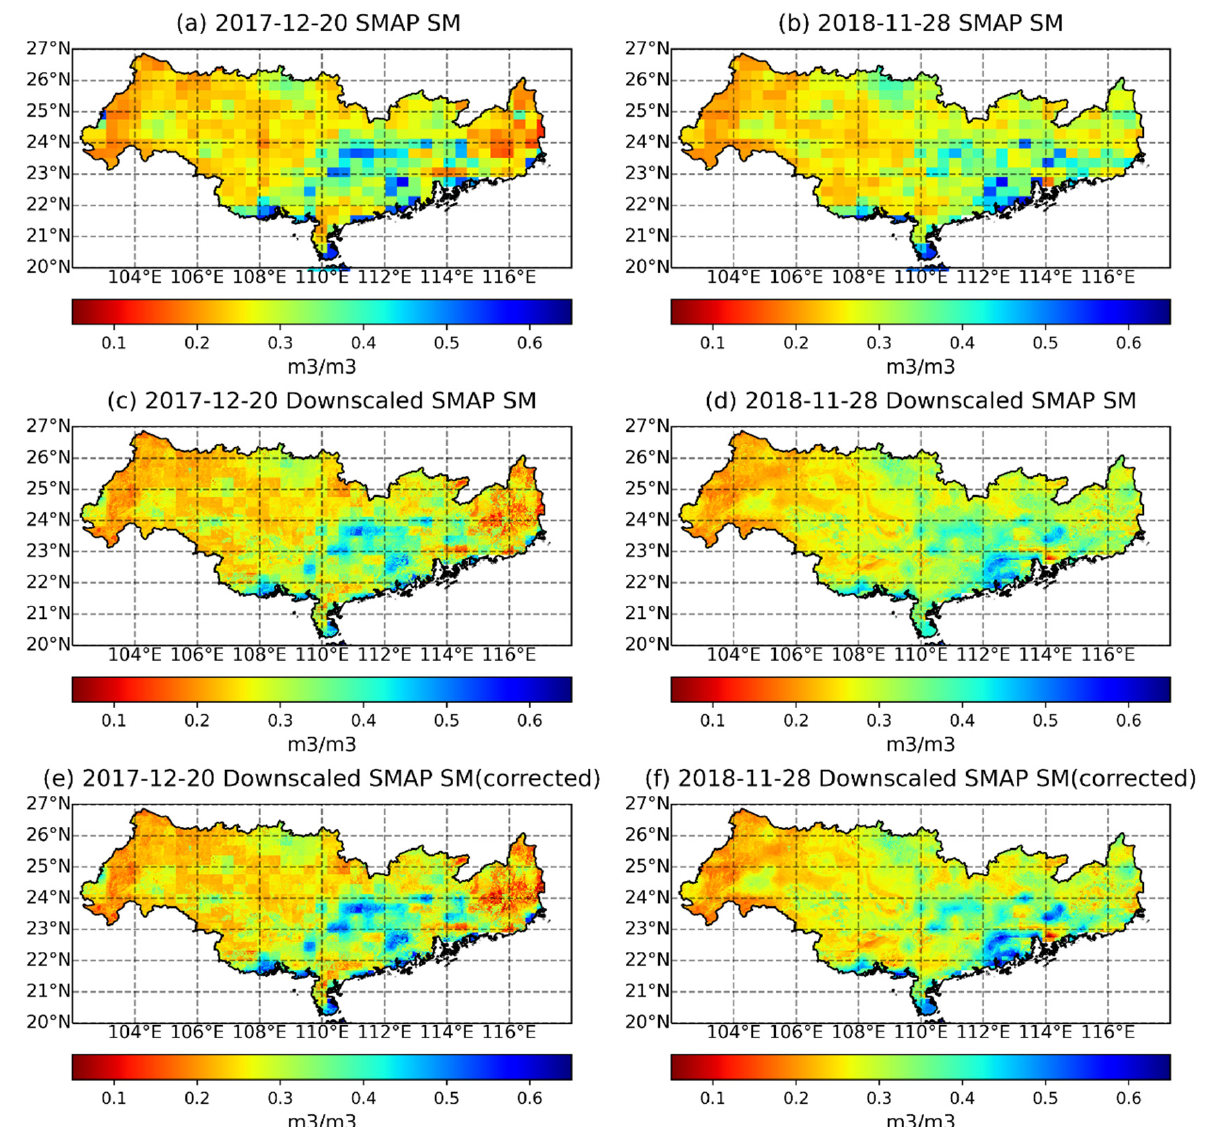
Figure 7. Distributions of the downscaled SM and the original SMAP SM on 20 December 2017 and 28 November 2018 (sunny).